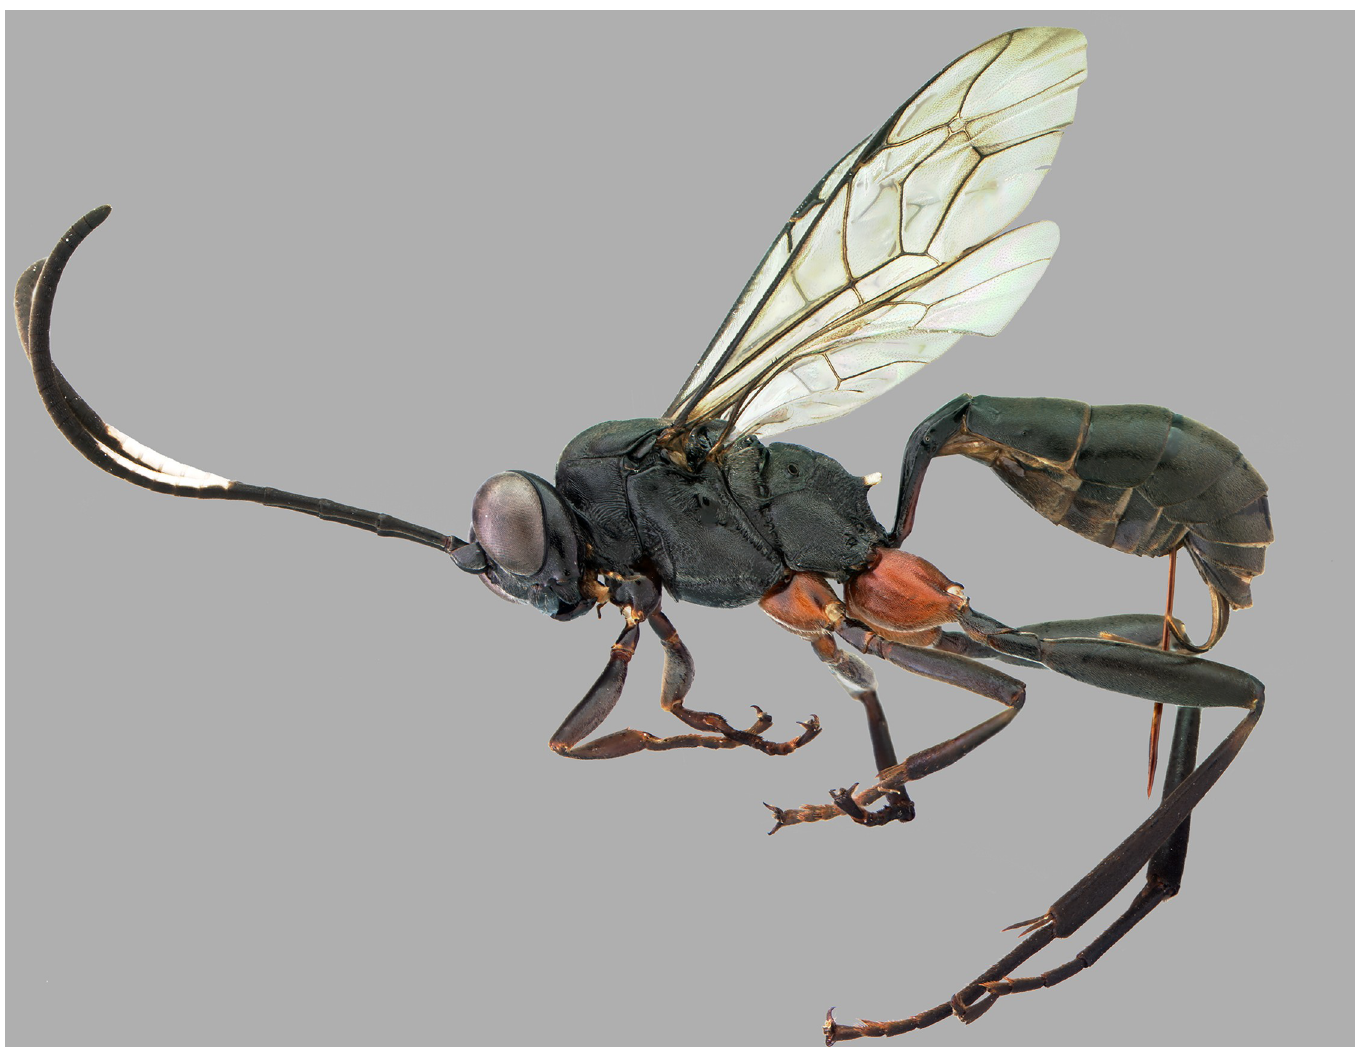
Fig 9. Holotype female of Cryptoxenodon metamorphus sp. nov. FAS1127, Alt. 561m, Brazil/ES. Habitus.